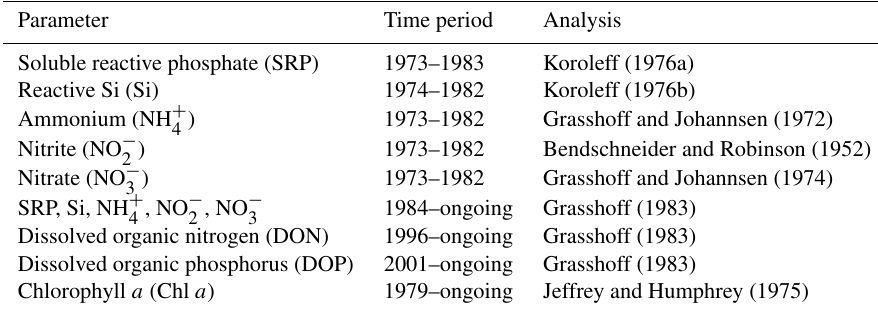
Table 2. Compilation of methods applied in the Sylt Roads time series.